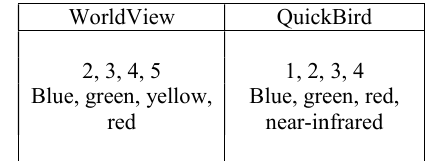
Table 1 . Bands of the satellite images.